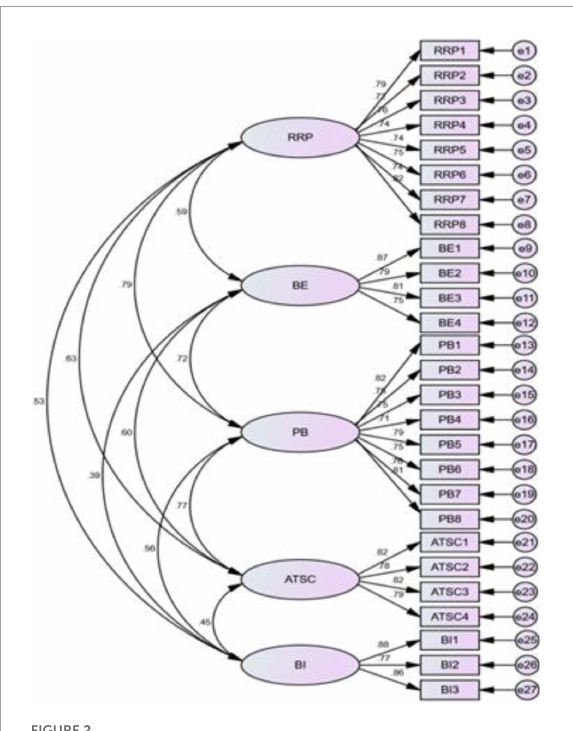
FIGURE2 Representation of the CFA Model. RRP, reduced risk perception; BE, benign envy; PB, perceived benefits; ATSC, attitude toward staycations; BI, behavioral